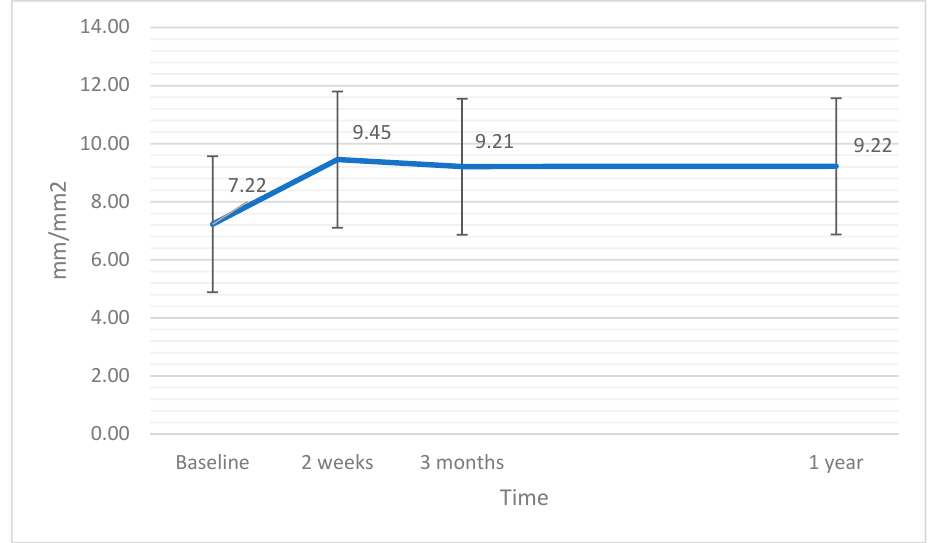
Figure 5. Vessel density in the central part of the retina (VDC) at baseline and after the surgery. The error bars represent 95% CI of the obtained results.